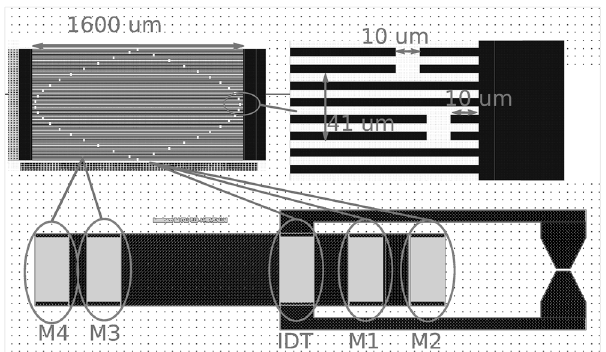
Figure 1. SAW sensor layout. The interdigitated transducer (IDT) is located between four mirrors (M1, M2, M3 and M4) positioned at different distances from the transducer in order to introduce different delays. The contact pads are used for the electrical connection of IDT. M1 acts for the reference measurement. The active areas between IDT and mirrors M1 or M3 and between mirrors M3 and M4 on the one hand, M1 and M2 on the other hand, are used for the deposition of the sensitive